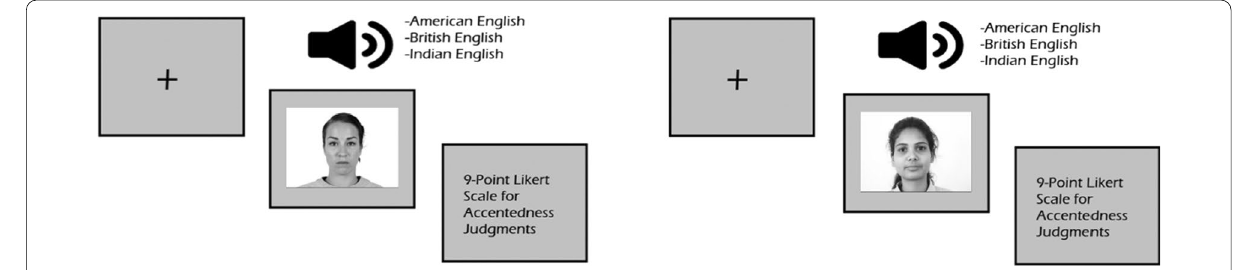
Fig. 3 The design of the accentedness task